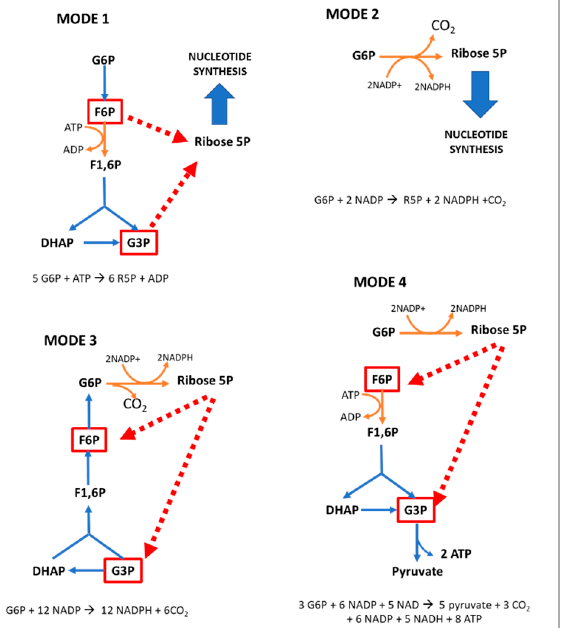
Figure 3. Pentose phosphate pathway regulation depends on cellular needs. MODE 1: This mode dominates when the need for R5P is higher than that for NADPH, for instance, in proliferative cells. In this situation, the glycolytic metabolites 3GP and F6P can be converted in R5P through the reversible non-oxidative PPP. The oxidative PPP and its associated NADPH formation are bypassed. MODE 2 : This mode occurs when the needs for NADPH and R5P are balanced. Then, ideally, from one molecule of G6P two molecules of NADPH and a molecule of R5P can be obtained with no generation of glycolytic metabolite. MODE 3 : This mode is adopted when the cellular need for NADPH exceeds that for R5P and ATP, for instance, during fatty acid synthesis in adipocytes. The non-oxidative phase of the pathway leads to the conversion of ribulose 5-phosphate to fructose 6- phosphate (F6P) and glyceraldehyde 3-phosphate (G3P). Then, these glycolytic metabolites—through gluconeogenesis reactions—form G6P, which can enter again into the PPP to produce more NADPH. MODE 4: In this scenario, the cellular need for NADPH and ATP is higher than that for R5P. As described in PPP mode 3, ribulose 5-P is transformed into G3P and F5P through the non-oxidative branch of the PPP; however, in mode 4, these molecules are metabolized to pyruvate through glycolysis, which is associated with ATP formation.